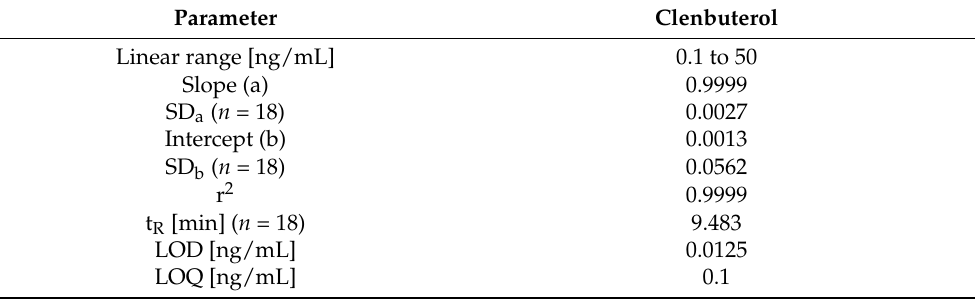
Table 2. Calibration parameters of the developed SPE–UHPLC–MS/MS method. Parameter Clenbuterol